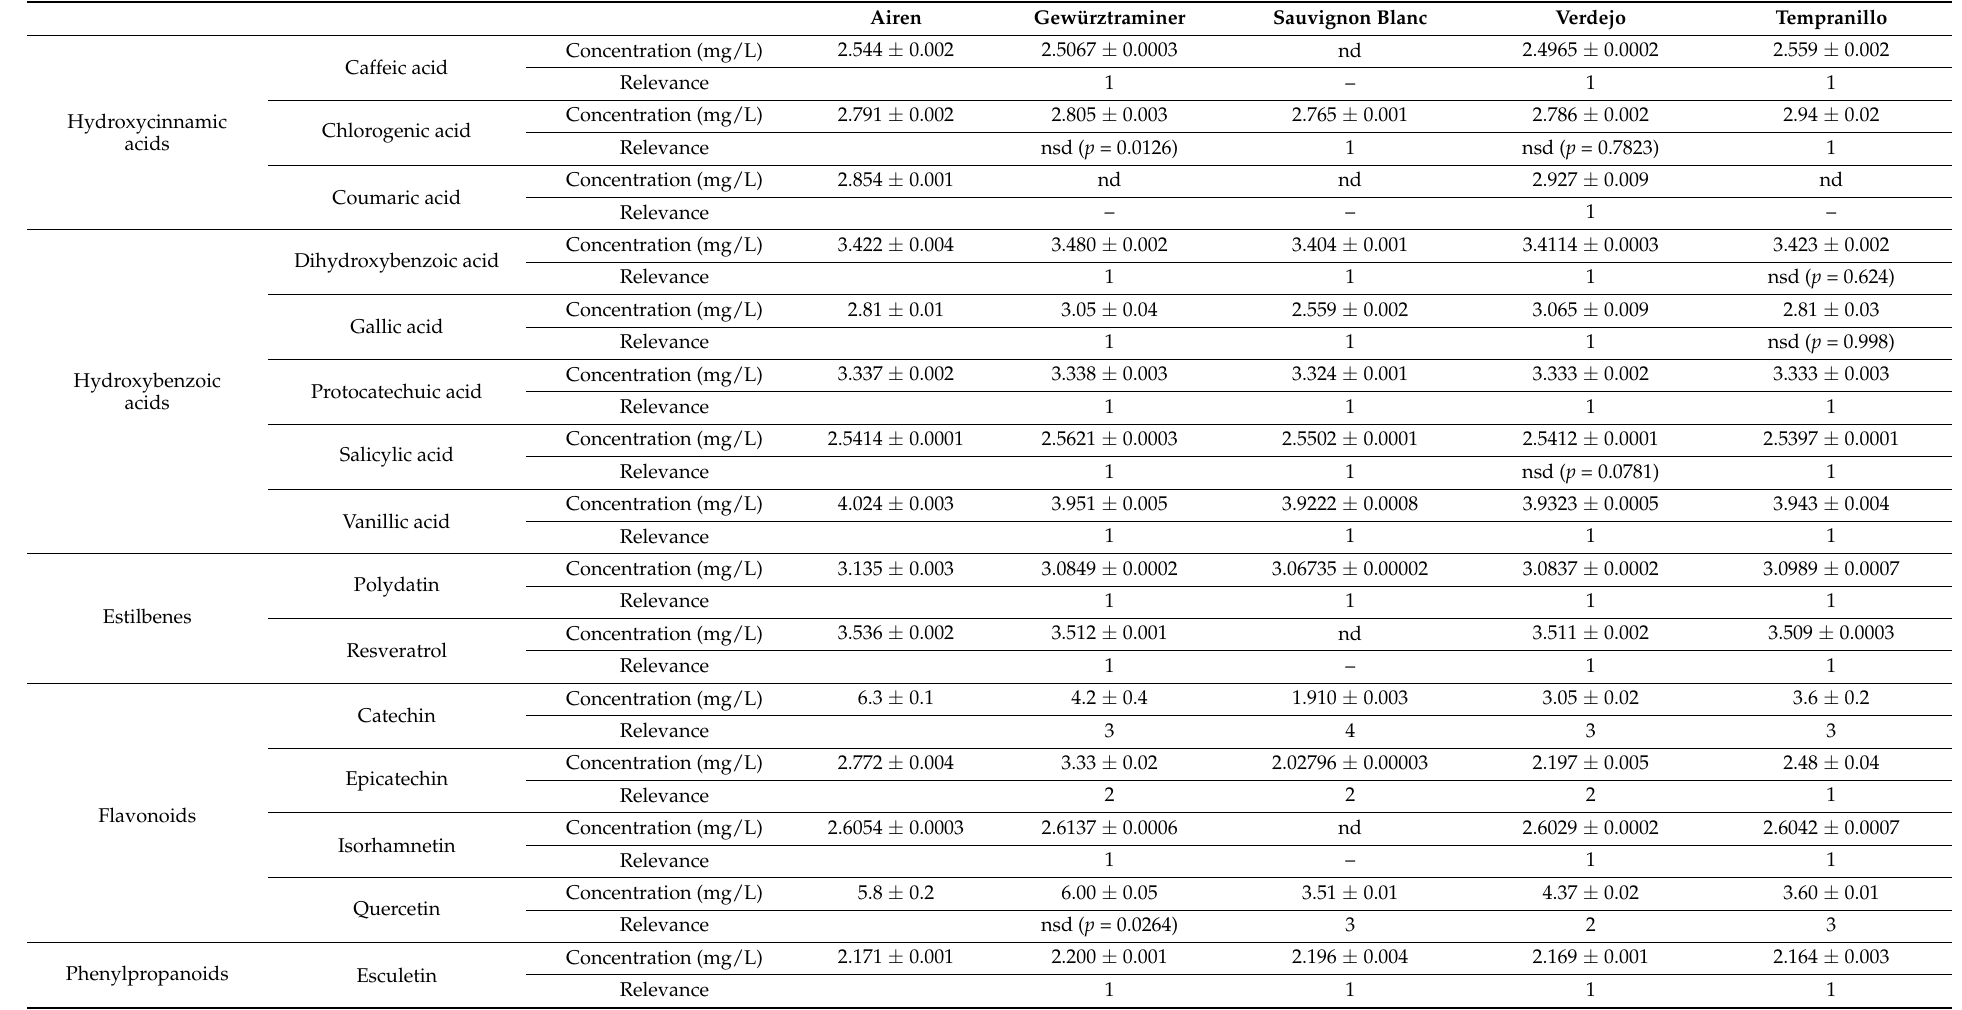
Table 3. Concentration of the 15 polyphenols identified in the grape juice extracts (mg/L ± standard deviation) including the relevance level of the determined differences. All p -values < 0.01 except those non-statistically different (nsd). nd